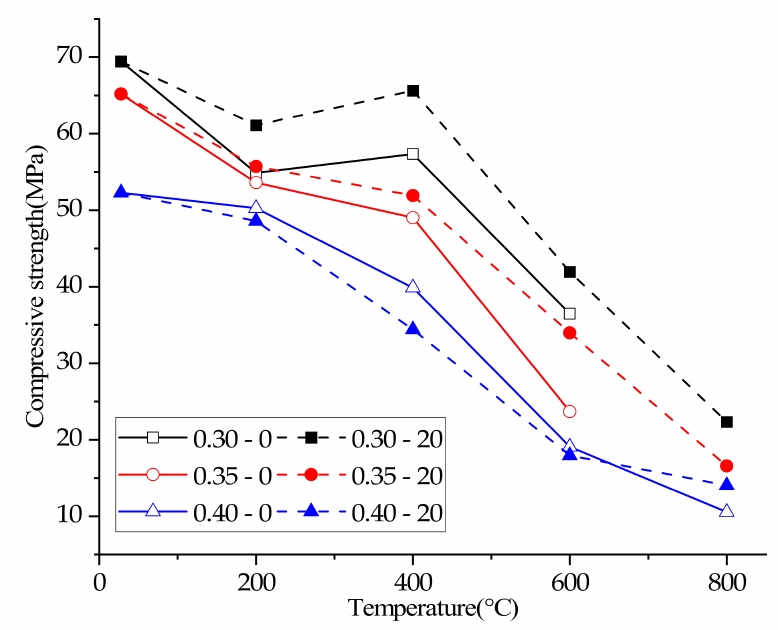
Figure 3. Compressive strengths of concrete